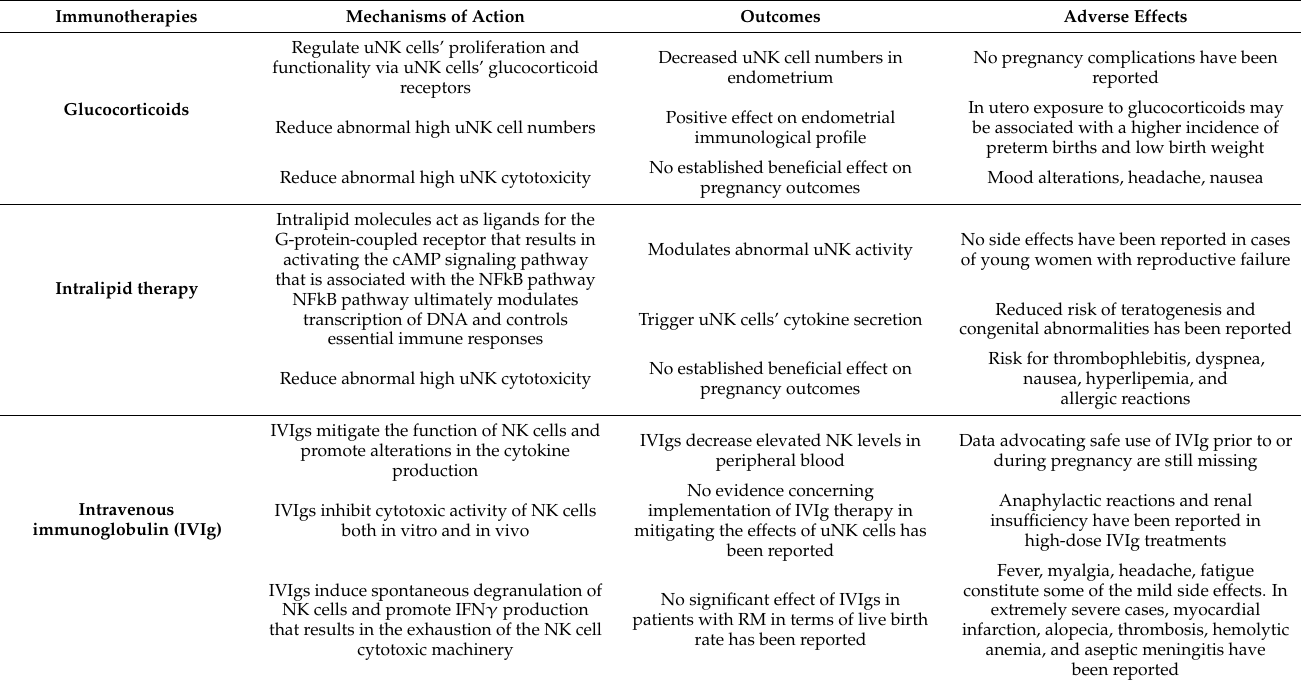
Table 3. Suggested immunotherapies for addressing uNK related RIF and